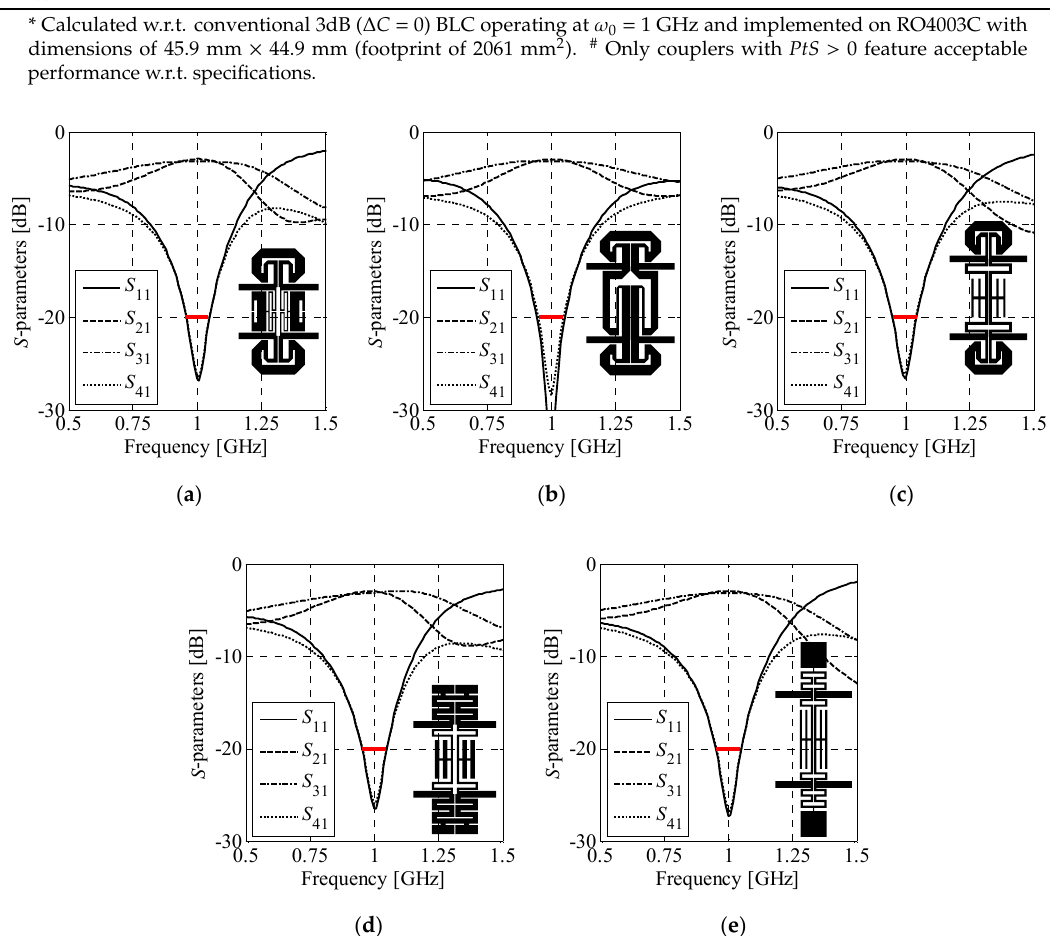
Table 2. Performance comparison of optimized compact BLCs.